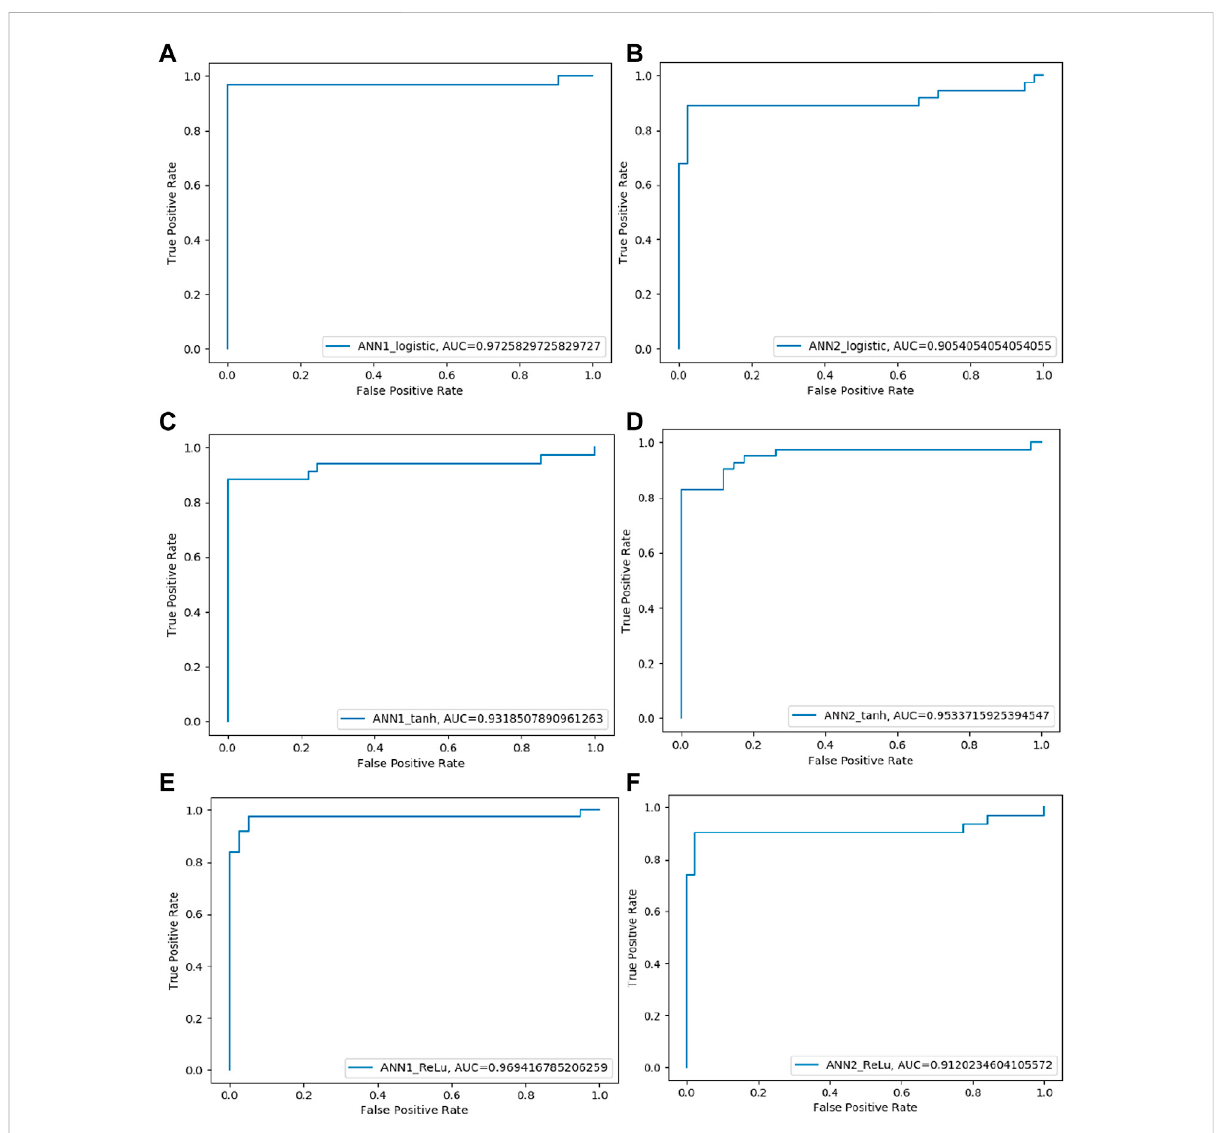
FIGURE 2 ROCcurveoffourSVMmodelsperformancebasedonAUCscore: (A) SVM-LinearmodelROCcurve (B) SVM-PolynomialmodelROCcurve (C) SVM-rbf model ROC curve (D) SVM-Sigmoid model ROC